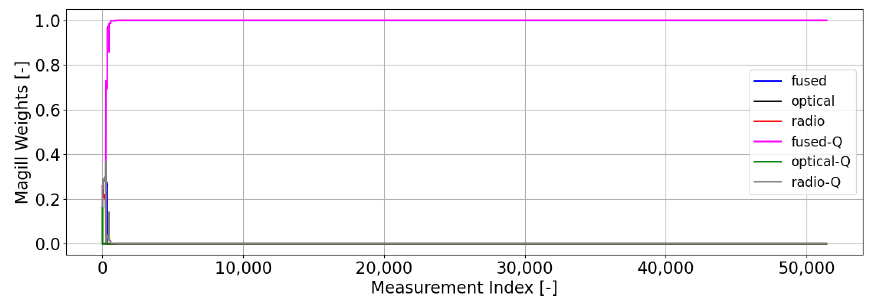
Figure 20. Magill gating network weights with attitude thruster